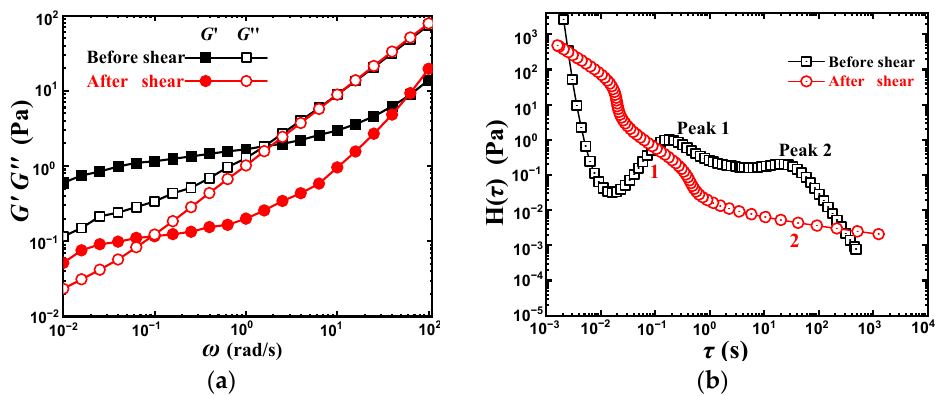
Figure 5. Dynamic rheological behavior and the corresponding relaxation spectrum of 10 wt% PVA before and after shear. ( a ) Dynamic rheological behavior. ( b ) Relaxation spectrum.